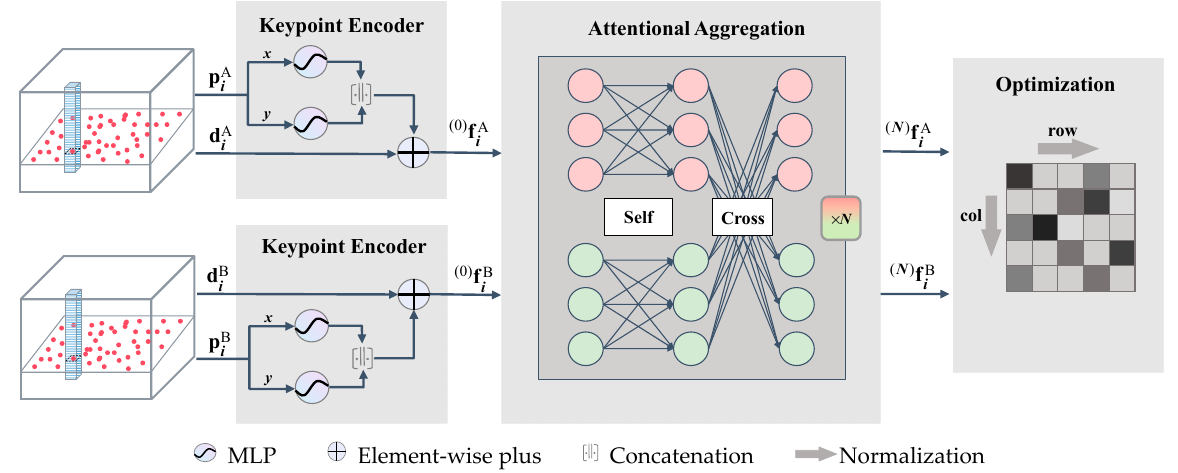
Figure 1. The CSAM architecture.